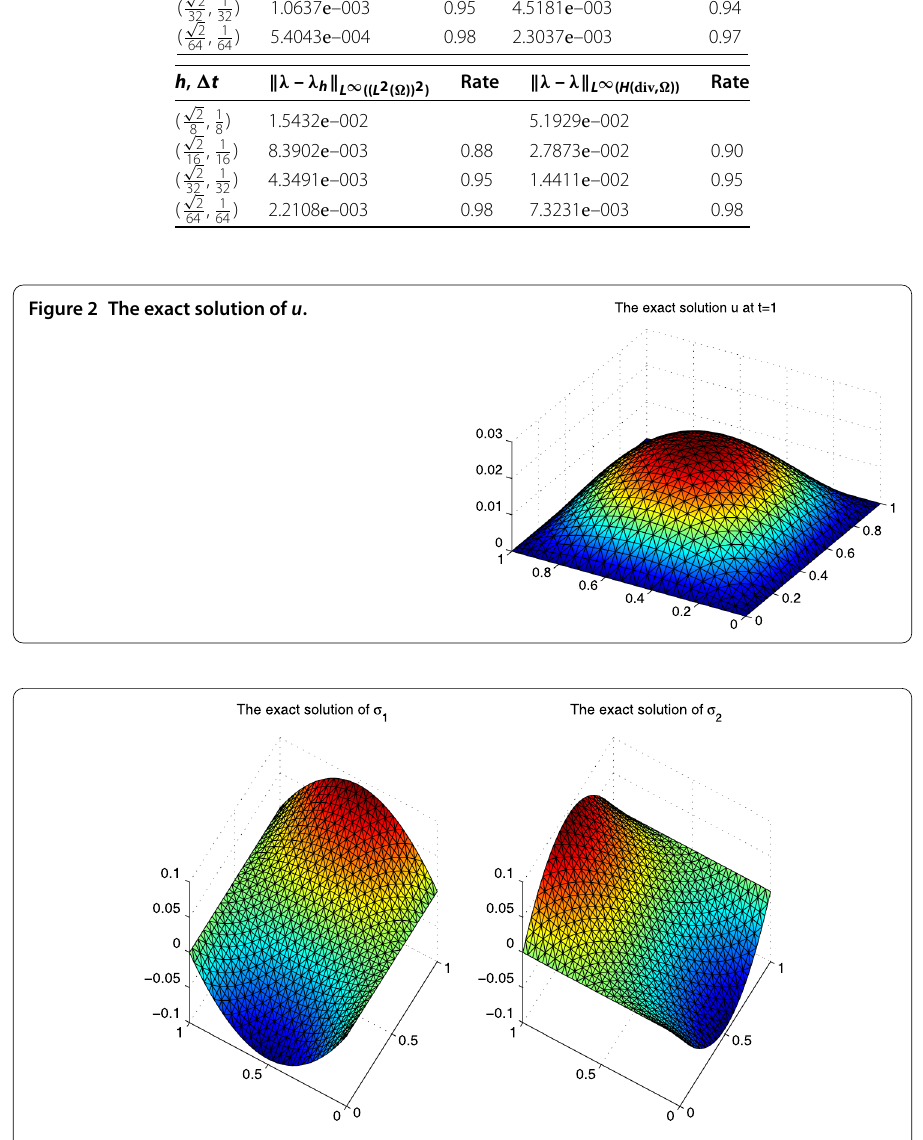
Figure 3 The exact solution of σ = ( σ 1 , σ 2